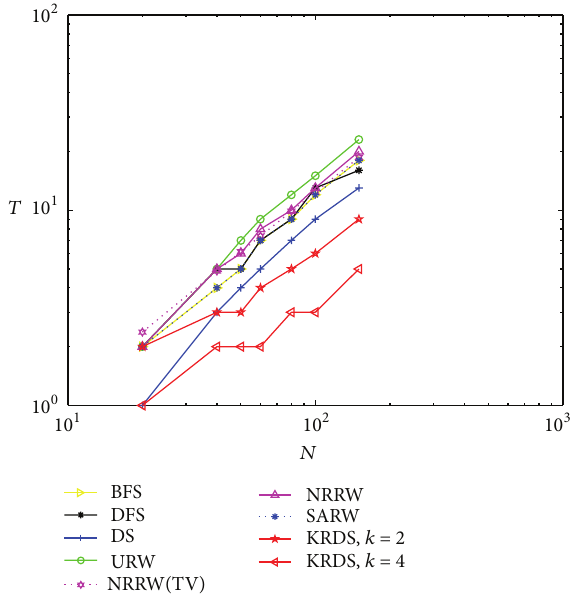
Figure 6: Plot of the average number 𝑇 of search steps versus the network size 𝑁 of the WSSWN with connection probability 𝑝 = 1 in the log-log